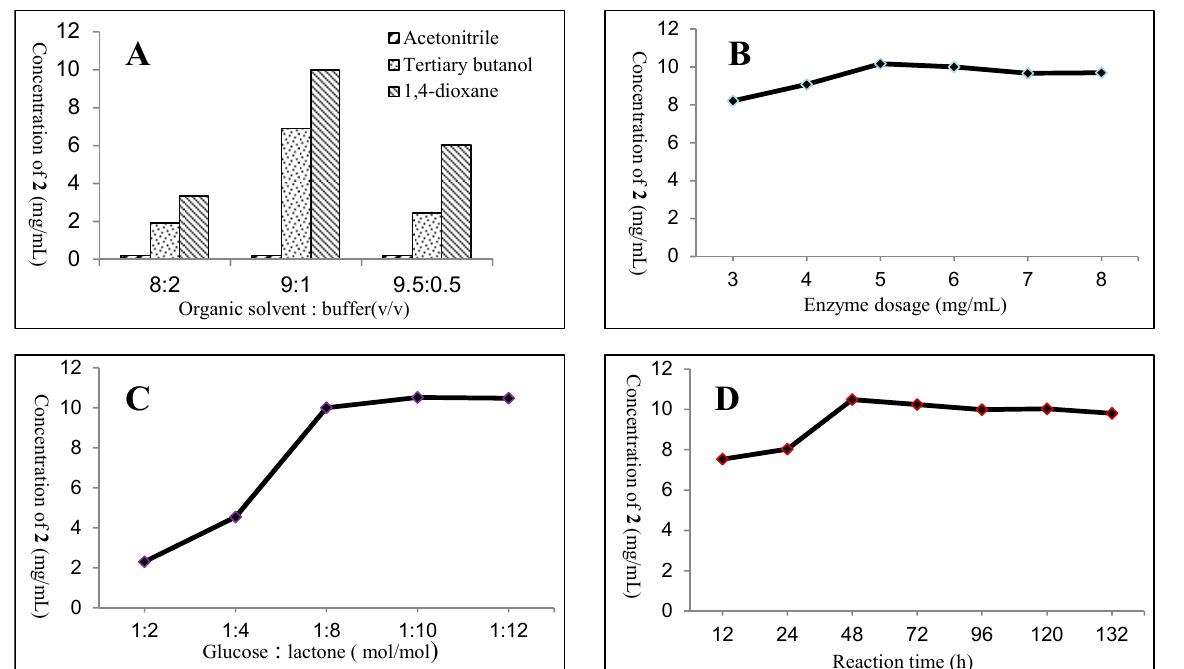
2 catalyzed by almond β - D -glycosidase in homogeneous systems; ( B ) effects of almond β - D -glycosidase dosages on the synthesis of 2 ; ( C ) effects of ( S )-3-hydroxy- γ -butyrolactone concentrations on the synthesis of 2 ; ( D ) Dependence of 2 formation on reaction time. For single factor experiments, when one factor was investigated, the best condition of the three other factors was